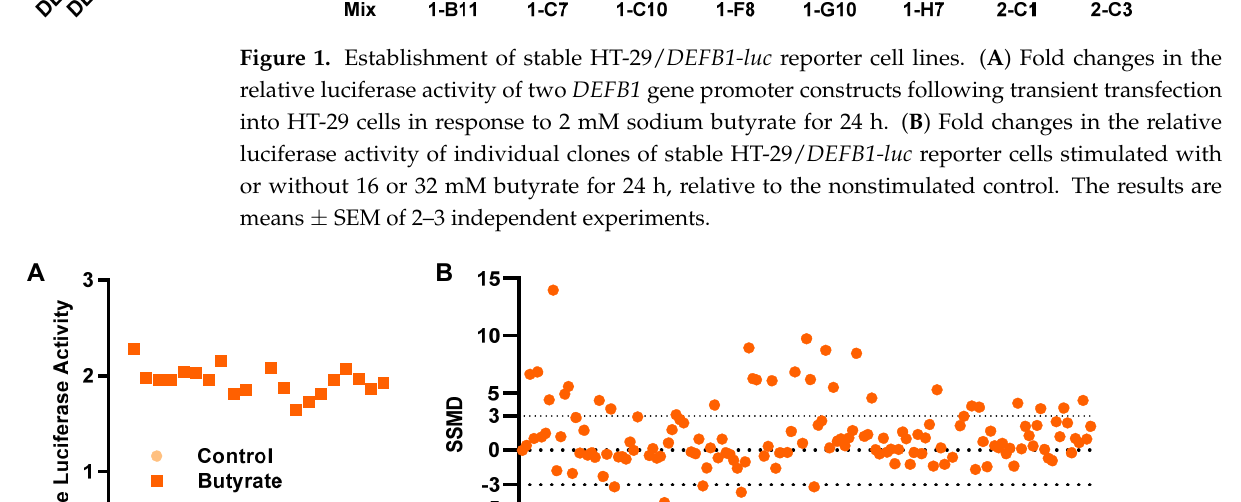
Figure 1. Establishment of stable HT-29/ DEFB1-luc reporter cell lines. ( A ) Fold changes in the rela- tive luciferase activity of two DEFB1 gene promoter constructs following transient transfection into HT-29 cells in response to 2 mM sodium butyrate for 24 h. ( B ) Fold changes in the relative luciferase activity of individual clones of stable HT-29/ DEFB1-luc reporter cells stimulated with or without 16 or 32 mM butyrate for 24 h, relative to the nonstimulated control. The results are means ± SEM of 2–3 independent experiments.